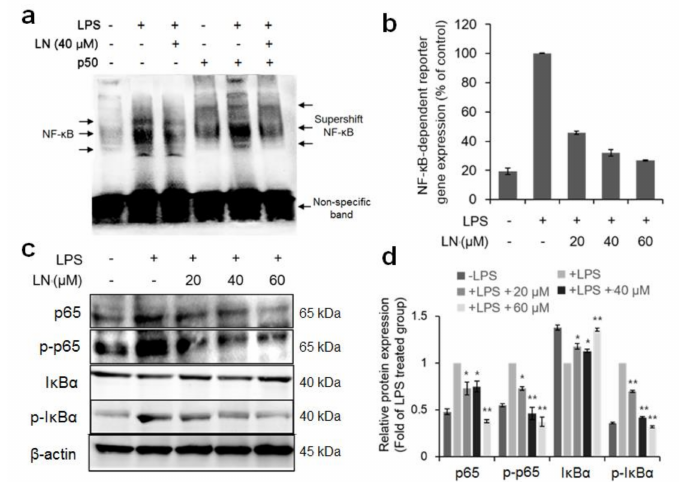
Figure 2. Lutonarin (LN) inhibited LPS-stimulated NF- κ B activation in RAW 264.7 macrophages. Cells were pretreated with the indicated LN concentrations for 4 h, then cultivated for 24 h with 1 µ g/mL LPS. ( a ) Effect of LN on NF- κ B DNA binding. Nuclear extracts of cells treated as indicated (LN, LPS, and/or anti-p50) were prepared and analyzed for NF- κ B activation by electrophoretic mobility shift assay (EMSA). LN dose-dependently reduced the supershift in the NF- κ B p50 com- ponent band; ( b ) Effect of LN on LPS-activated NF- κ B-dependent reporter gene expression. LN dose-dependently blocked LPS-induced luciferase activity driven by the NF- κ B gene promoter in RAW 264.7 macrophages; ( c ) LN also suppressed the expression of NF- κ B subunit p60, the negative regulator IkBa, and corresponding phosphorylated forms as evidenced by Western blot analysis. β -actin was used as the gel-loading control; ( d ) Densitometric analysis of Western blots. LN dose-dependently reversed the LPS-induced elevations in p65, p-p65, and p-I κ B α and reversed the LPS-induced reduction in I κ B α suggesting inhibition of degradation. Values are presented as the mean ± SEM of three independent replicates (* p < 0.05 and ** p < 0.01 by ANOVA).